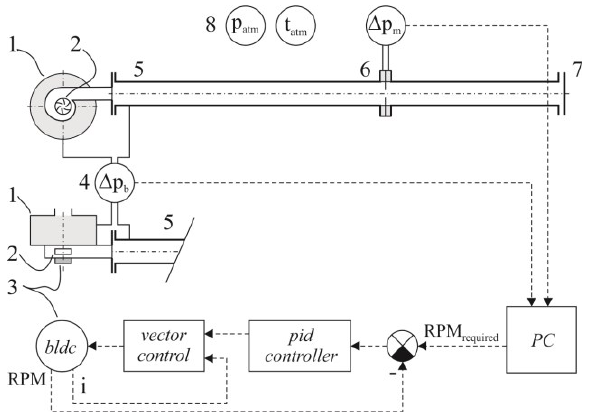
Fig. 5 Testing stand: 1 – suction chamber with filter assembling, 2 – fan wheel, 3 – brushless DC motor, 4 – working pressure measuring ( p  ) , 5 – outflow tube, 6 – Fig. 6 Fan output for different way of engine control. b differential pressure p  measuring for mass flow m specification, 7 – chocking, 8 – measuring of atmospheric pressure and temperature.